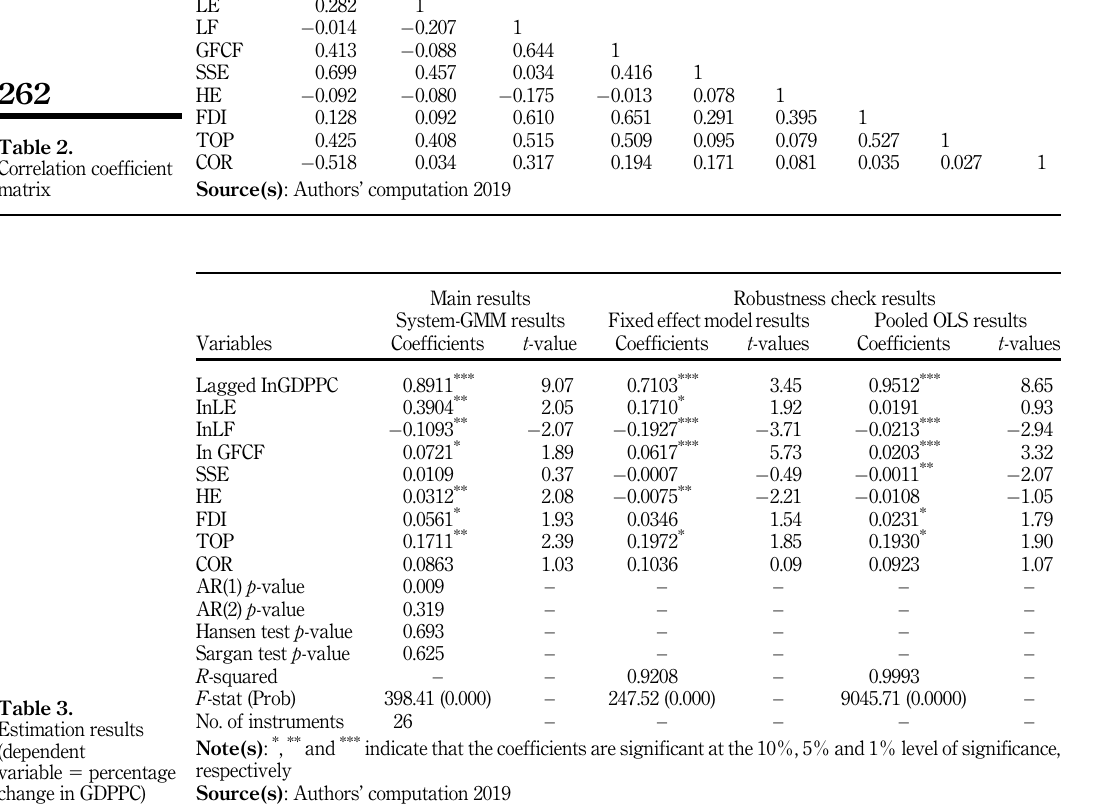
Table 3. Estimation